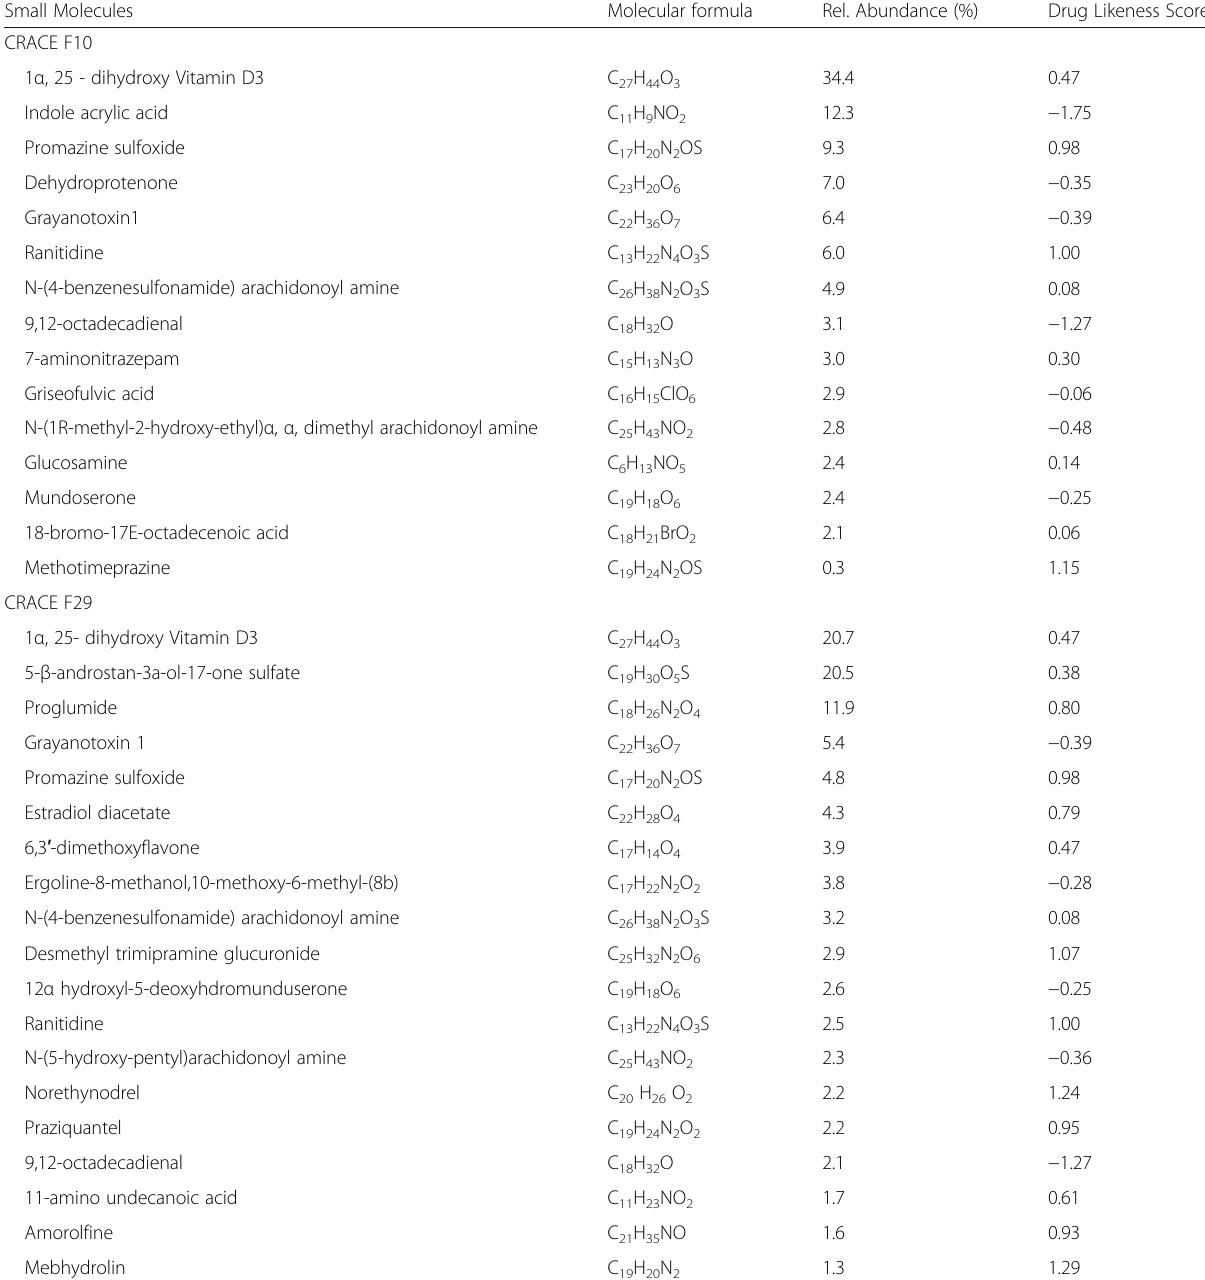
Table 1 List of abundant small molecules present in CRACE fraction F10 and F29 and their relative abundance observed by HR- LCMS analysis Small Molecules Molecular